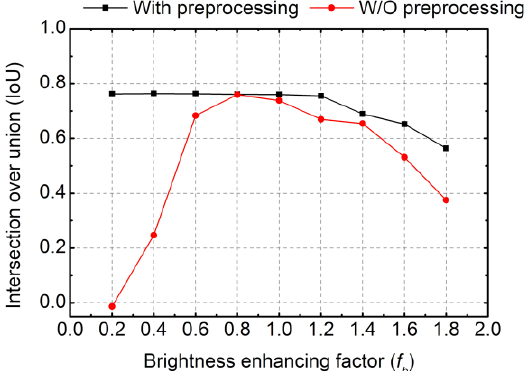
Figure 10. Comparison of the IoUs obtained with and without the image preprocessing model.